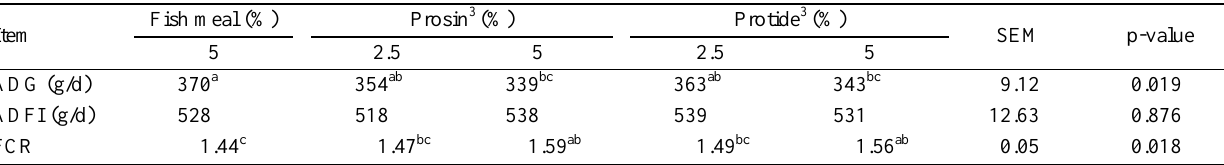
Table 7. Effects of single-cell proteins (Prosin and Protide) replacing fish meal in diet on growth performance of weaned piglets, Exp. 3 1 Fish meal (%) Prosin 3 (%) Item